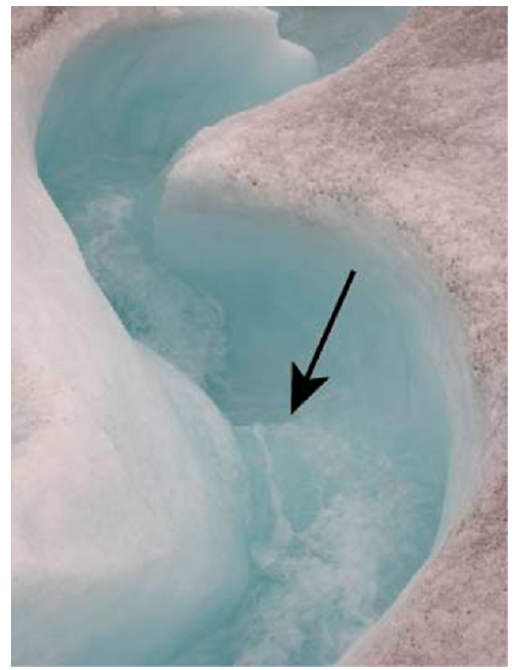
Figure 7. Development of a knickpoint in a supraglacial meander bend at Austre Brøggerbreen, August 2007. Flow direction is away from the photographer. Channel width is approximately 40cm at the